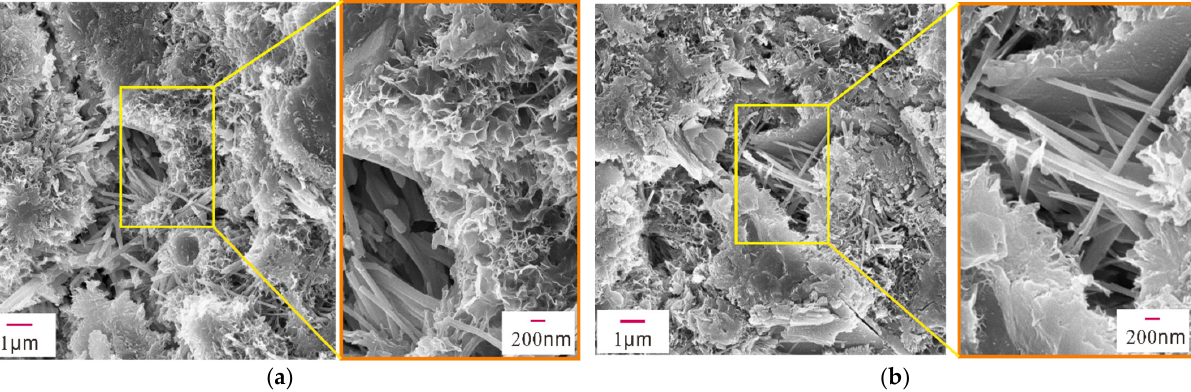
Figure 6. SEM images of sample 3N. ( a ) Partial SEM image of sample 3N, ( b ) Partial SEM image of sample 3N.